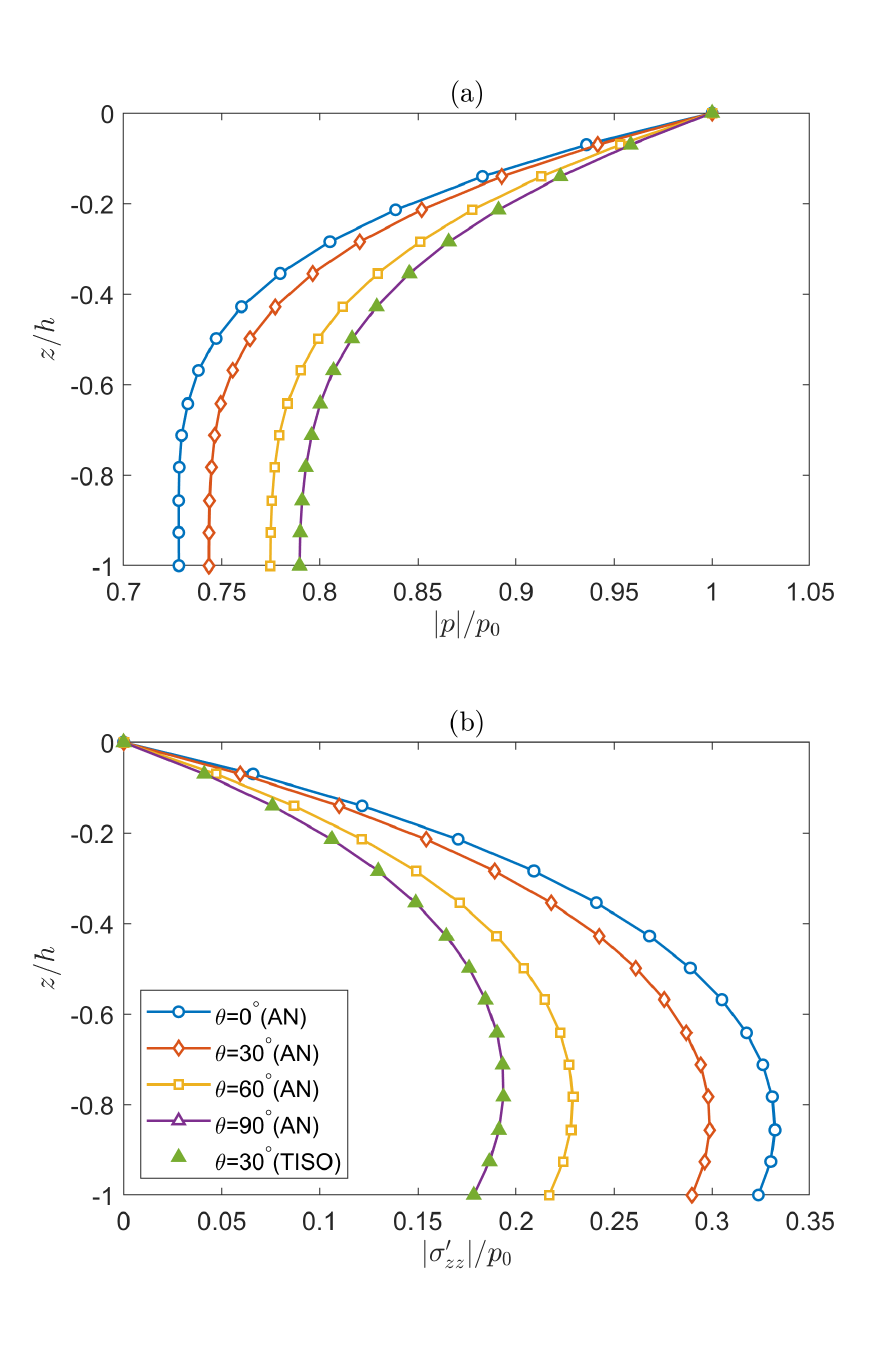
Figure 7. Comparison of ( a ) pore pressure p and ( b ) vertical effective stress σ (cid:48) zz for different wave directions between AN and TISO permeabilities (for the AN cases, θ = 0 ◦ ,30 ◦ ,60 ◦ , and 90 ◦ correspond respectively to Cases 4, 2, 5, and 6; the TISO of θ = 30 ◦ corresponds to Case